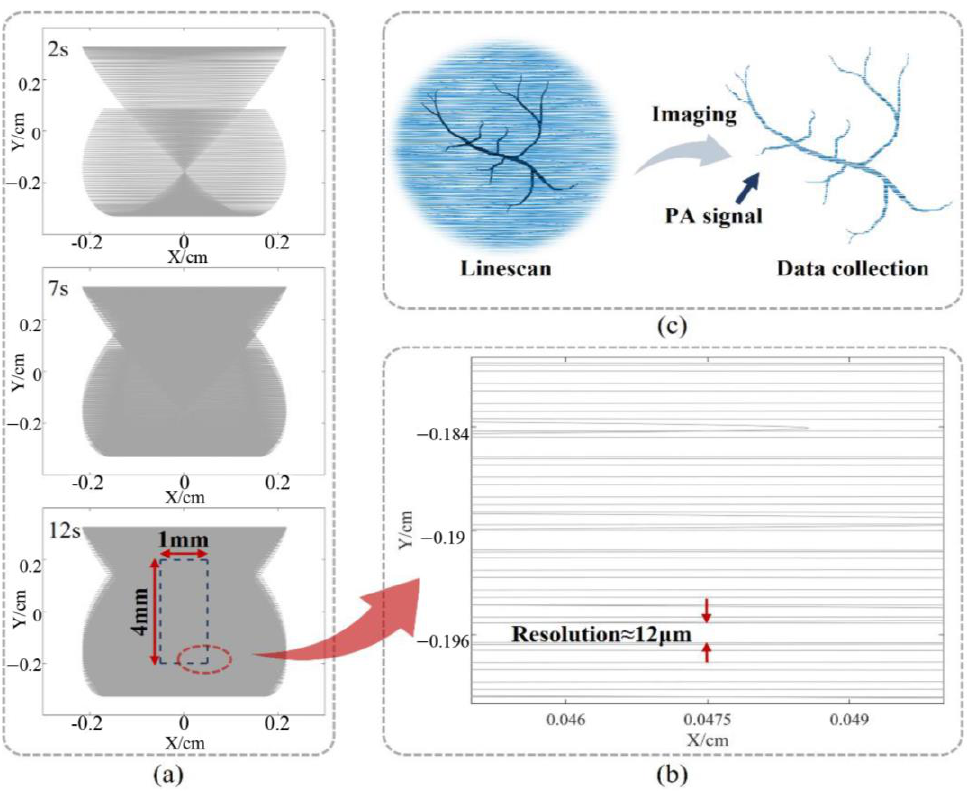
Figure 11. The imaging simulation of “ Z ” type. ( a ) The scan state changes over time and results in an effective imaging area of 1 mm × 3 mm at 14 s. ( b ) The edge area of the effective imaging area, indicating the resolution of the image is better than 9 μm. ( c ) The image simulation of a blood vessel sample.